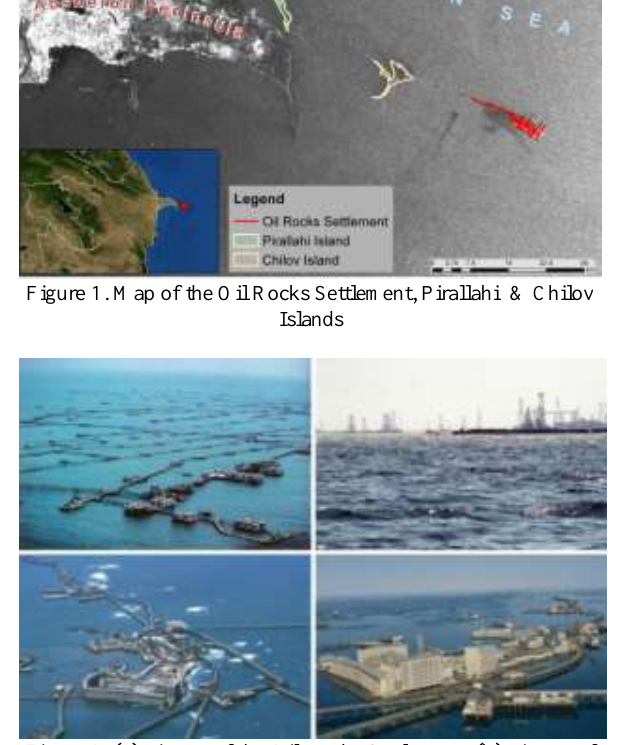
Figure 2. (a) Picture of the Oil Rocks Settlement; (b) Picture of Pirallahi & Chilov Islands